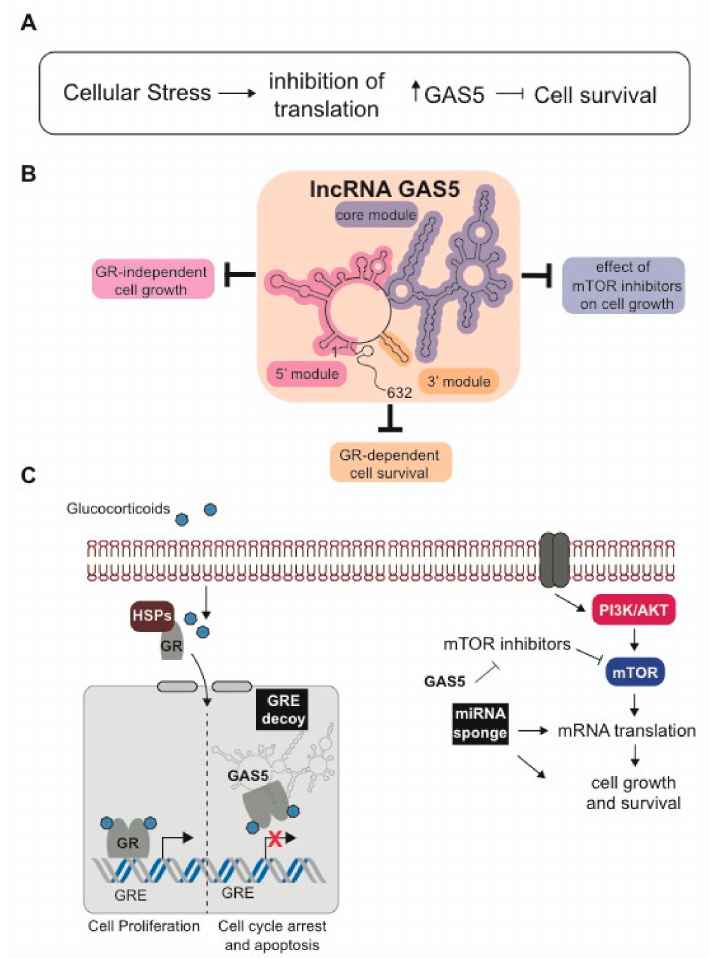
Figure 3. GAS5 lncRNA regulates cellular stress responses through multiple mechanisms. ( A ) Various cellular stressors, including serum or nutrient deprivation as well as various drug treatments, result in the inhibition of translation and the accumulation of GAS5 transcripts, whereby GAS5 negatively regulates cell proliferation and survival. ( B ) The GAS5 RNA molecule comprises three separate regions that mediate the effect of GAS5 on cell growth through distinctive mechanisms. These regions are divided into 3 modules: a 5 (cid:48) unstructured region, a highly structured core region, and a 3 (cid:48) terminal glucocorticoid receptor (GR) binding region. Functional analysis indicates that the 5 (cid:48) module mediates the effect of GAS5 on basal cell survival and reducing the rate of cell cycle, whereas the core module is required for mediating the effects of mTOR inhibitors. ( C ) The mechanisms by which GAS5 regulate cell proliferation in GR-dependent (left) and GR-independent means (right) are shown. For the GR-dependent process, GAS5 functions as a glucocorticoid response element (GRE) decoy effectively sequestering GR from GRE elements in DNA and suppressing GR-dependent gene expression and cellular proliferation. For the GR-independent growth control, GAS5 can function as a miRNA sponge to regulate signaling pathways. Additionally, inhibition of the mTOR pathway downstream of PI3K/AKT signaling depends on